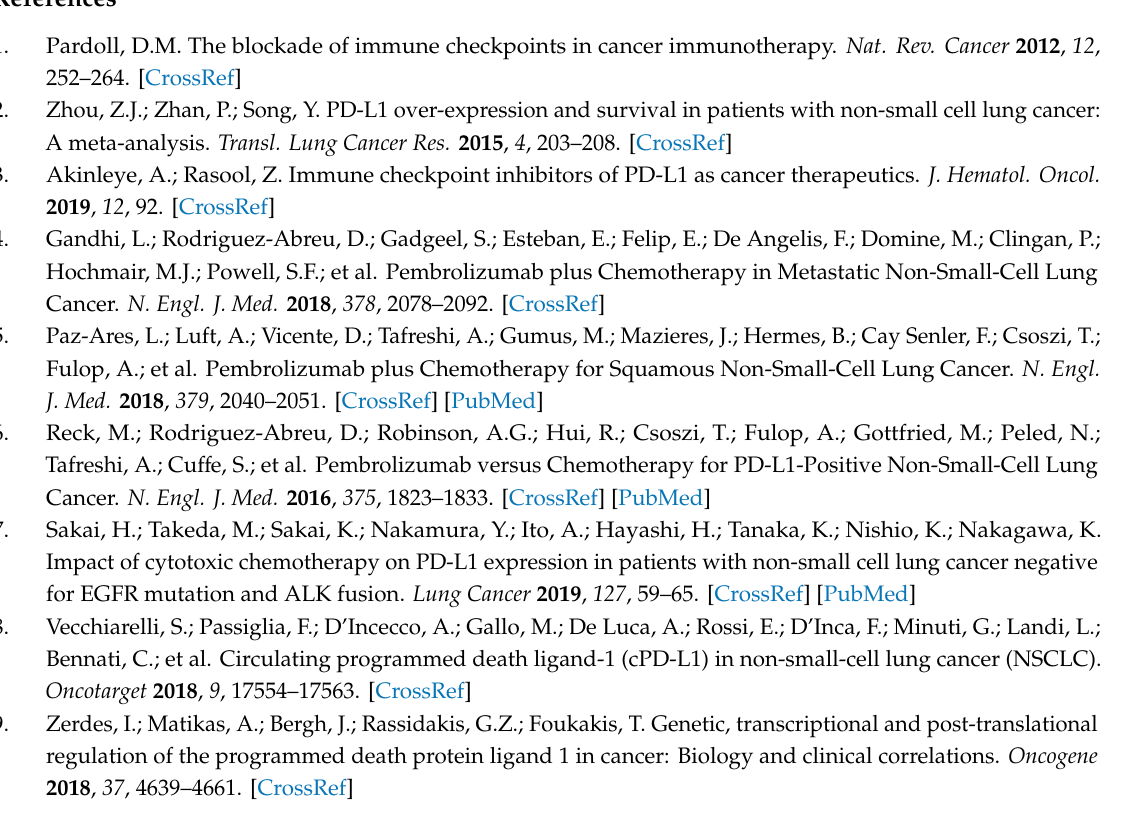
Figure S1: PD-L1 modulation by IFN- γ in NSCLC cell lines, Figure S2: PD-L1 induction by mTOR and STAT3 signaling activation, Figure S3: Tumor cells and PBMC non-contacting and contacting co-culture, Figure